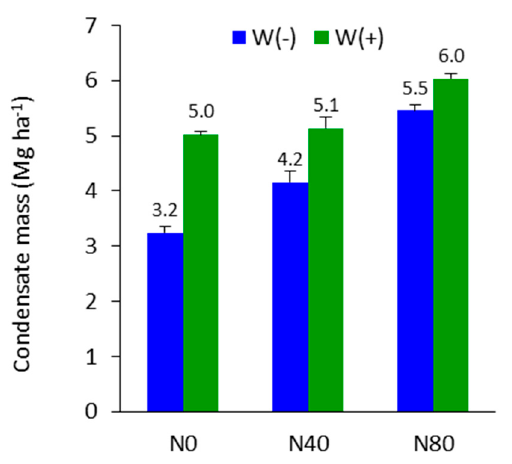
Figure 6. Mass of condensate from syngas formed.